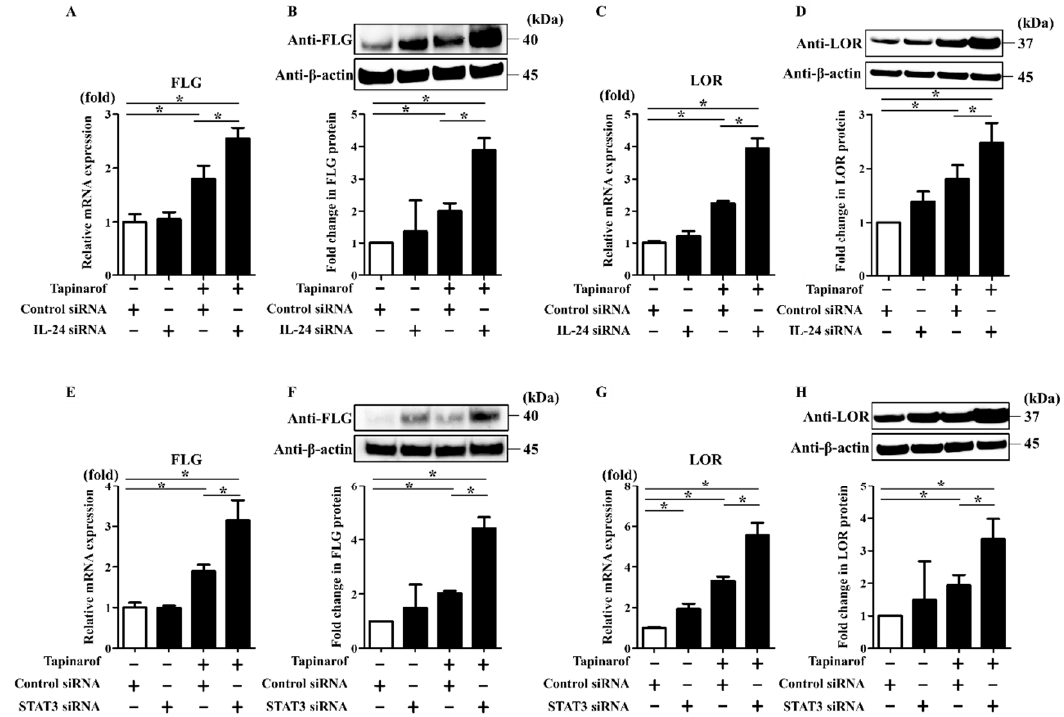
Figure 3. Inhibition of IL-24 and STAT3 enhanced tapinarof-induced upregulation of FLG and LOR expression in NHEKs. NHEKs were transfected with control siRNA (si-control) and siRNA against IL-24 (si-IL-24) ( A – D ) or STAT-3 (si-STAT3) ( E – H ) and subsequently treated with tapinarof (500 nM) for 96 h. ( A , C , E , G ) FLG and LOR mRNA levels were assessed by qRT-PCR. Representative data of three independent experiments with similar results are shown. ( B , D , F , H ) FLG and LOR protein levels were analyzed by Western blotting. ( Upper ) Representative blot images of three independent experiments with similar results are shown. ( Lower ) FLG or LOR protein levels are normalized to β -actin protein levels using ImageJ and expressed as fold change over the control group. ( A – H ) Error bars represent mean ± standard deviation; n = 3 for each group. Statistically significant di ff erences are presented: * p <